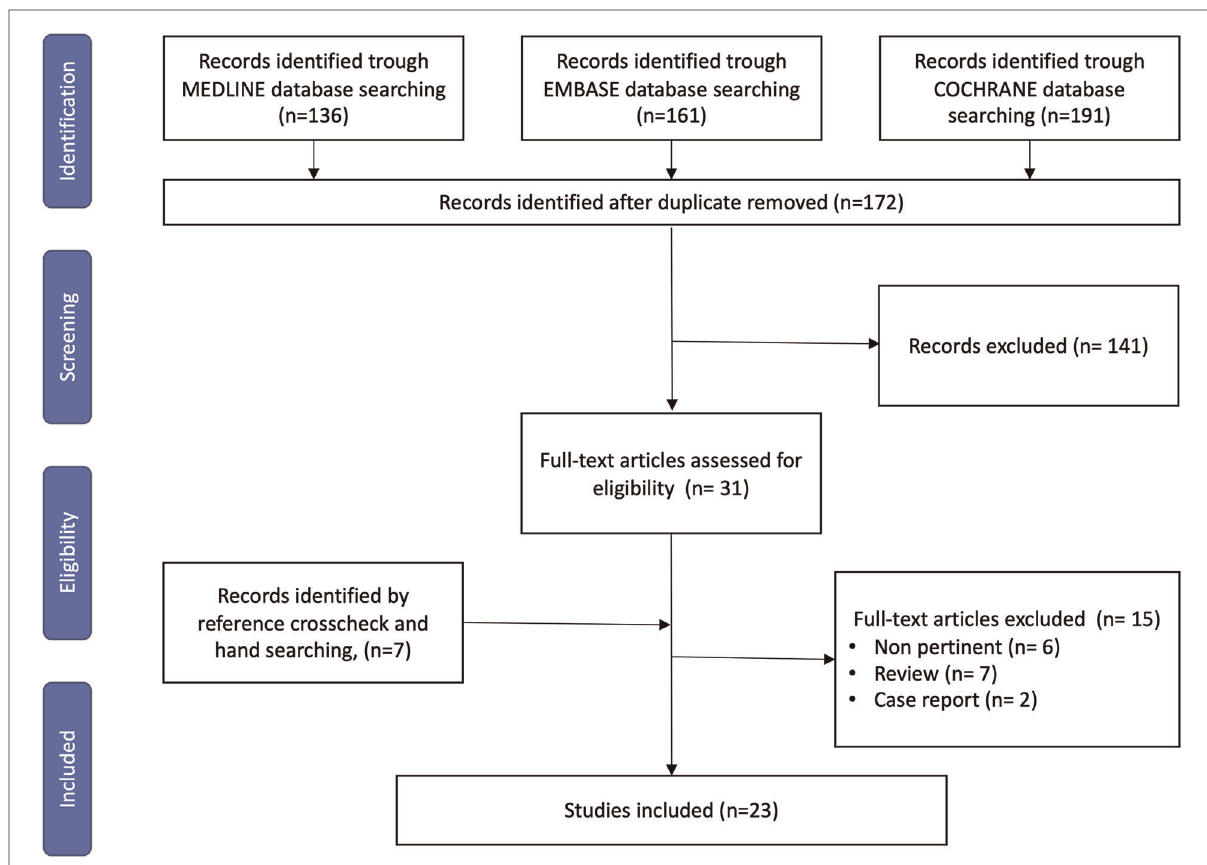
FIGURE 1 PRISMA fl ow diagram for study search, selection, inclusion, and exclusion. Example of the research strategy: ((robotic[Title/Abstract])) OR (robotic surgery[Title/Abstract])) OR (robotics[Title/Abstract])) OR (robotic procedure[Title/Abstract])) OR (minimally-invasive surgery[Title/Abstract]))) AND ((((((((((((((((total proctocolectomy[Title/Abstract]) OR (subtotal colectomy[Title/Abstract])) OR (total colectomy[Title/Abstract])) OR (completion proctectomies[Title/Abstract])) OR (completion proctectomy[Title/Abstract])) OR (ileal pouch-anal anastomosis[Title/Abstract])) OR (multiquadrant surgery[Title/Abstract])) OR (multiquadrant abdominal surgery[Title/Abstract])) OR (loop ileostomy[Title/Abstract])) OR (restorative proctocolectomy [Title/Abstract])) OR (restorative coloproctectomy[Title/Abstract])) OR (proctocolectomy[Title/Abstract])) OR